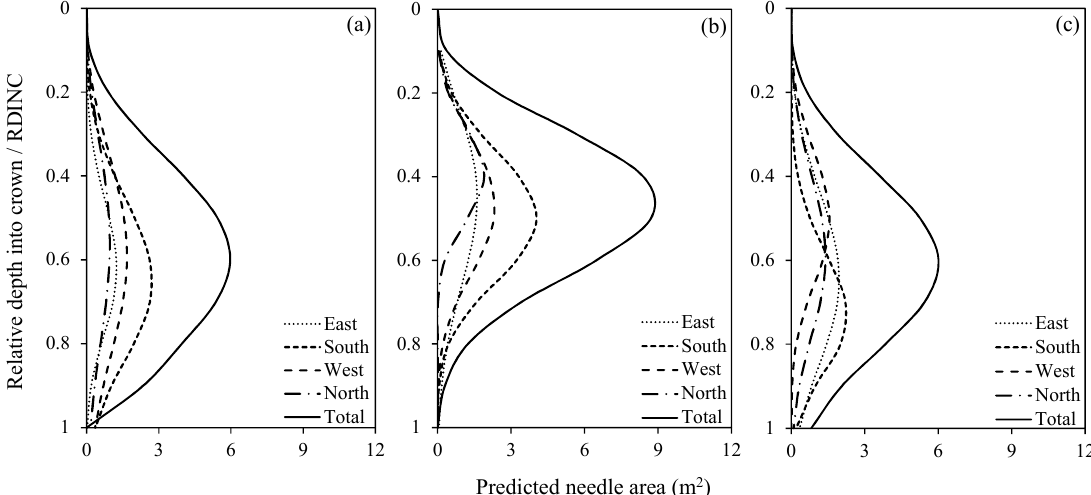
Figure 4. Vertical distribution of predicted needle area (NA), according to RDINC at intervals of 0.1 in different directions for three sample trees: ( a ) tree 1; ( b ) tree 2 and ( c ) tree 3.